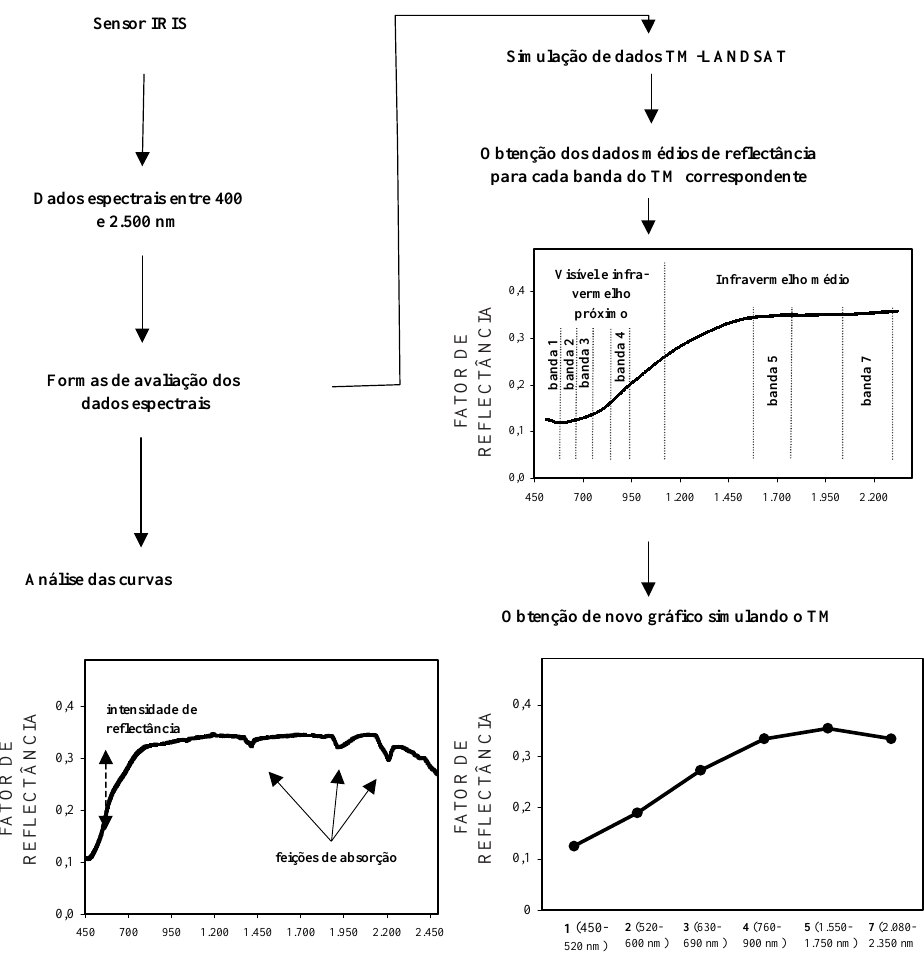
COMPRIMENTO DE ONDA, Figura 1. Obtenção das curvas espectrais pelo Sensor IRIS e simulação do TM-Landsat-5.